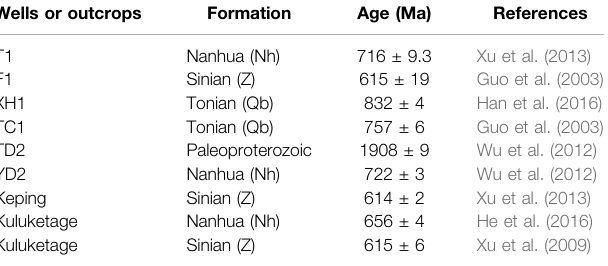
TABLE 1 | U-Pb zircon age data from the Tarim Basin. Wells or outcrops